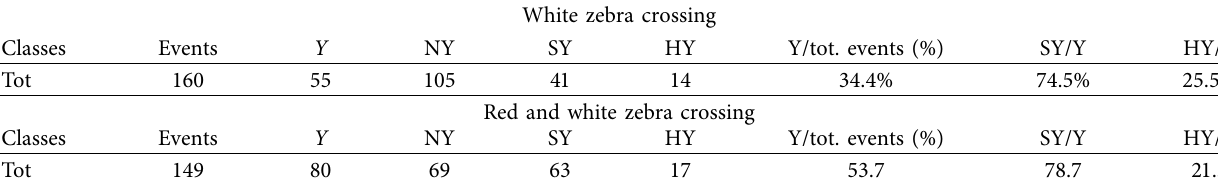
Table 1: Recorded events in two